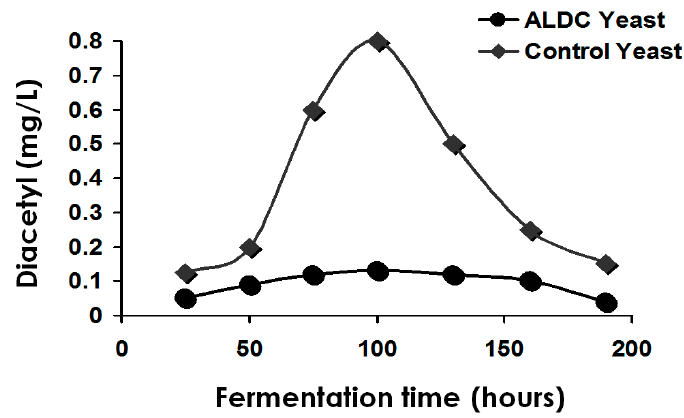
Figure 17. Effect of α -acetolactate decarboxylase (ALDC) on wort fermentation rate and extent [112].